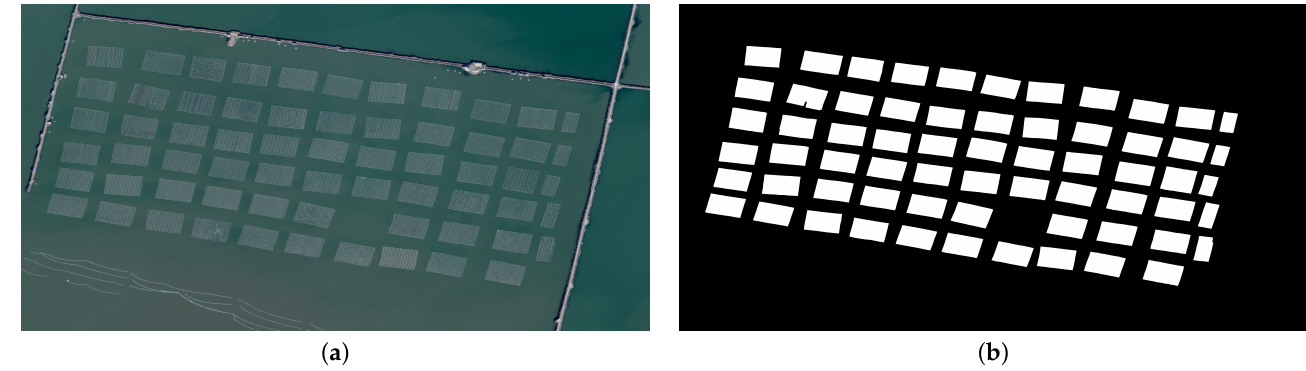
Figure 1. An example of semantic segmentation: ( a ) original image; ( b ) semantic segmentation